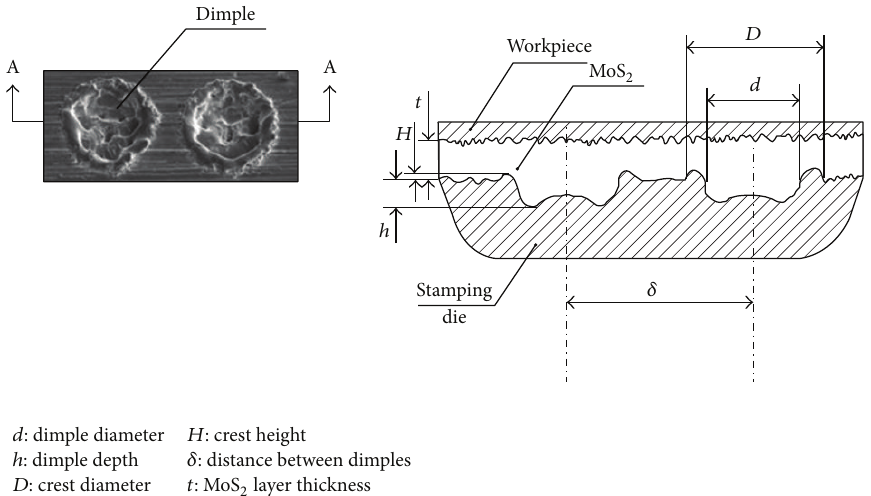
Figure 1: Parameters for the laser surface texturing of hot stamping dies.